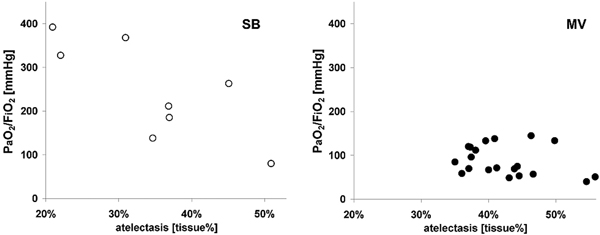
PaO2/FiO2 plotted against the proportion of atelectatic lung tissue. Open circles, SB; solid circles, MV.